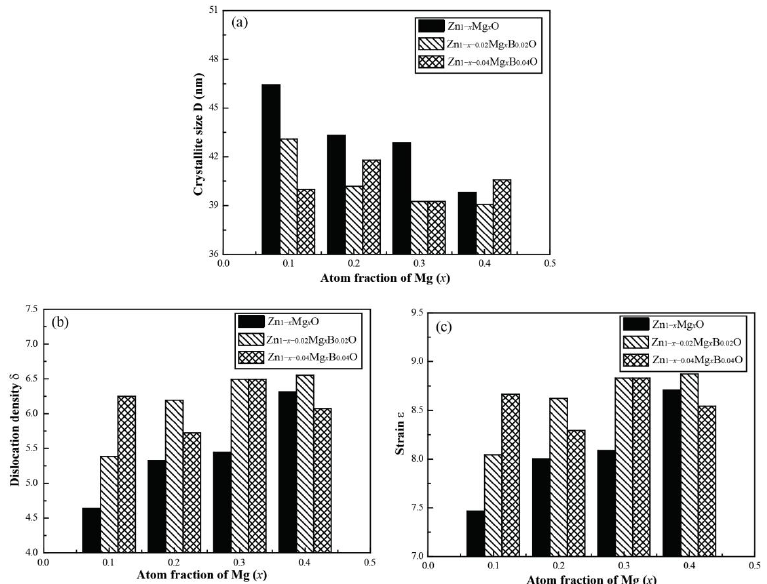
Figure 2. Comparison of calculated parameters of Zn 1− x − y Mg x B y O with different fraction of Mg. ( a ) crystallite size D; ( b ) dislocation density; ( c ) strain.